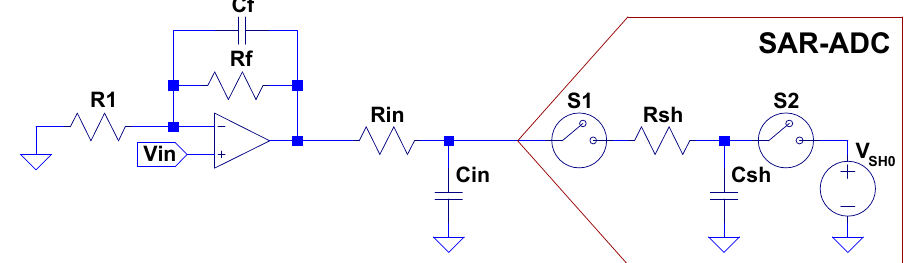
Figure 1. Successive approximation register (SAR) analog-to-digital converter (ADC) input driving circuit recommended by